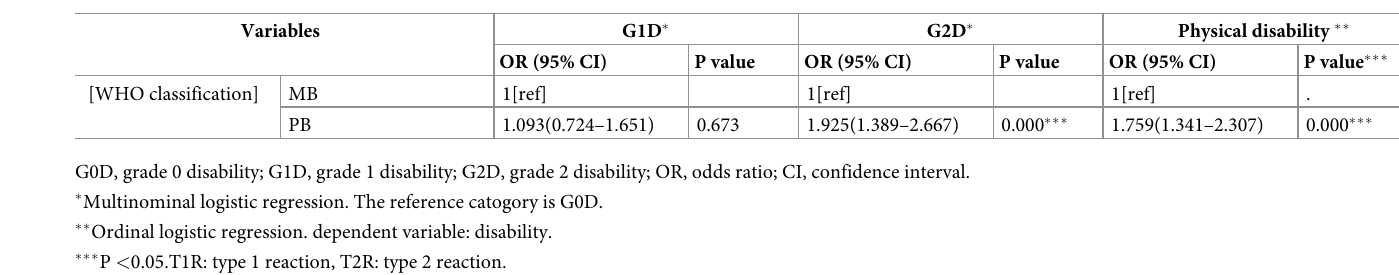
Table 2 also summarizes the results of risk factors associated with physical disabilities (com- bined G1D and G2D) by ordinal logistic regression. Advanced age, rural occupation,